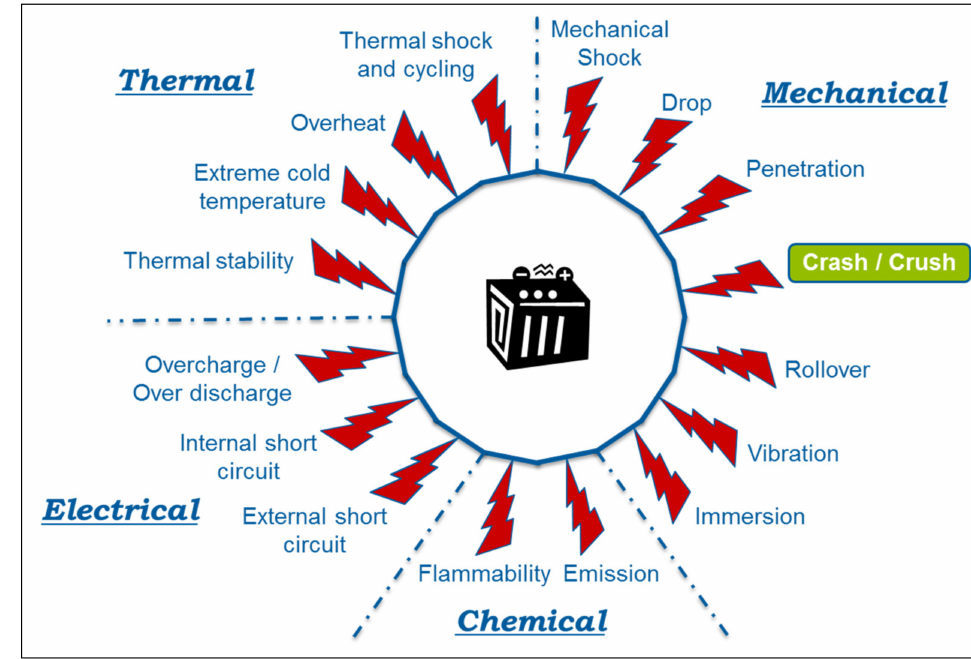
Figure 1. Abuse tests for the battery as per different standards and regulations